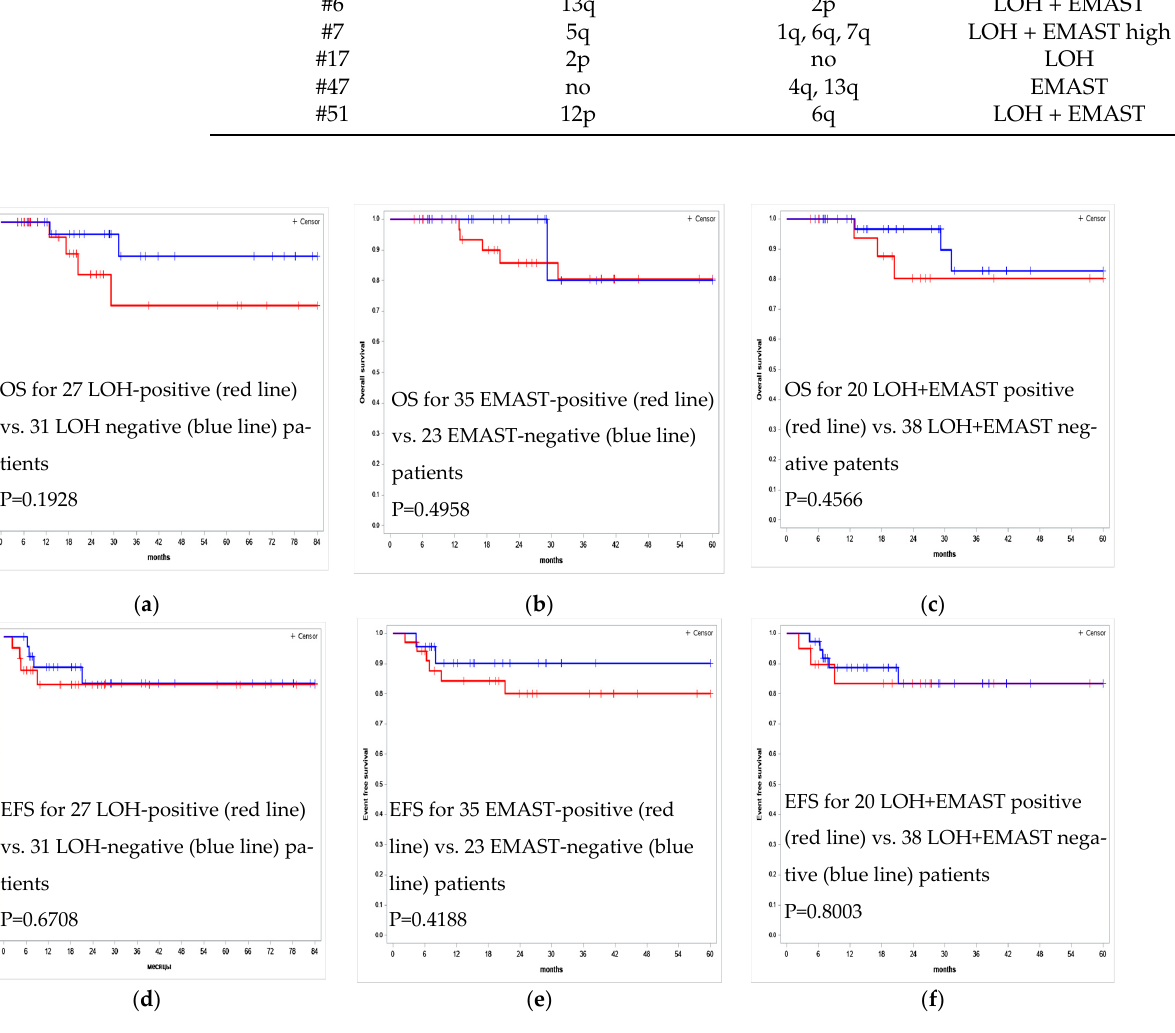
Figure 5. Kaplan–Meier survival curves for OS and EFS estimates according to the LOH and EMAST status in tumor STR profile for 58 PMBCL patients undergoing R-Da-EPOCH-21 therapy. ( a ) OS for 27 LOH-positive vs. 31 LOH negative patients ( b ) OS for 35 EMAST-positive vs. 23 EMAST-negative patients ( c ) OS for 20 LOH + EMAST positive vs. 38 LOH + EMAST negative patents ( d ) EFS for 27 LOH-positive vs. 31 LOH-negative patients ( e ) EFS for 35 EMAST-positive vs. 23 EMAST-negative patients ( f ) EFS for 20 LOH + EMAST positive vs. 38 LOH + EMAST negative patients. OS at 24 months was 100% in the group with a LOH-high status, compared to 87% in the control group ( p = 0.26), while EFS was 100% and 80% ( p = 0.16), respectively. No The LOH and EMAST status of patients (yes/no test) was not associated with OS statistically significant differences in the OS and EFS scores were found between the groups with different LOH-high statuses. Kaplan–Meier survival curves for the EFS and OS estimates according to the LOH-high and EMAST-high status in the tumor STR profile are presented in Figure 6.